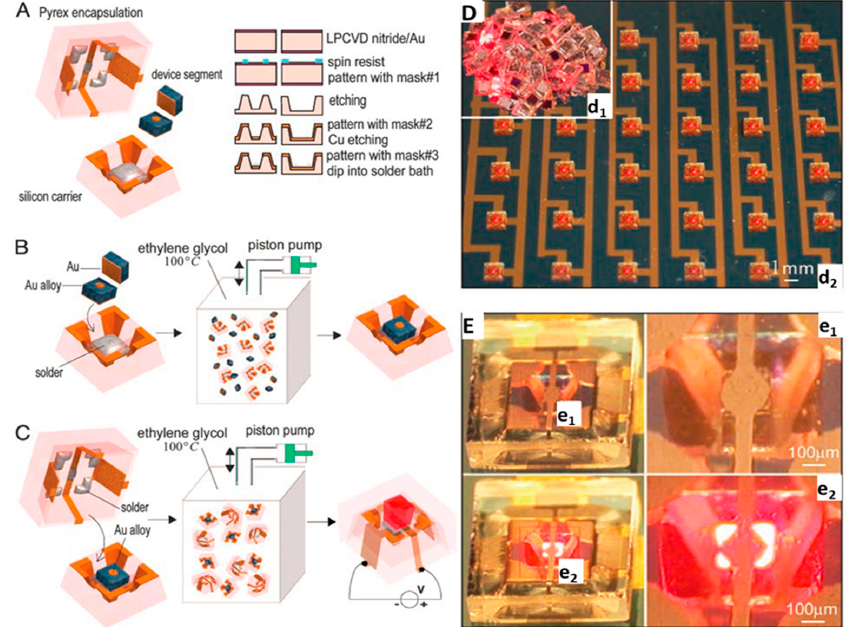
Figure 2. Fabrication strategy to assemble and package integrated semiconductor devices